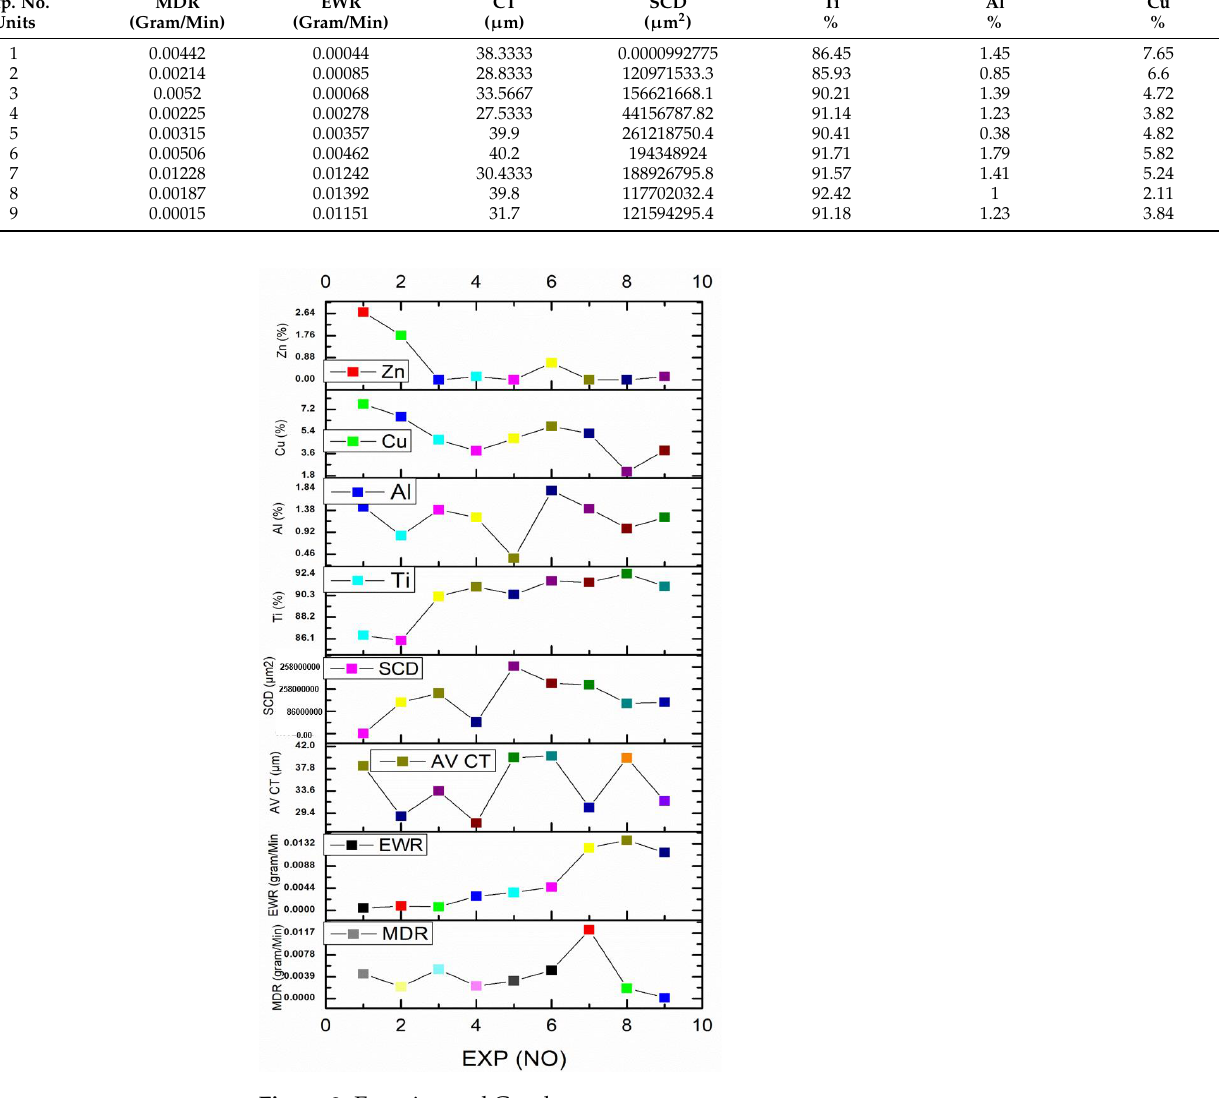
Figure 2. Experimental